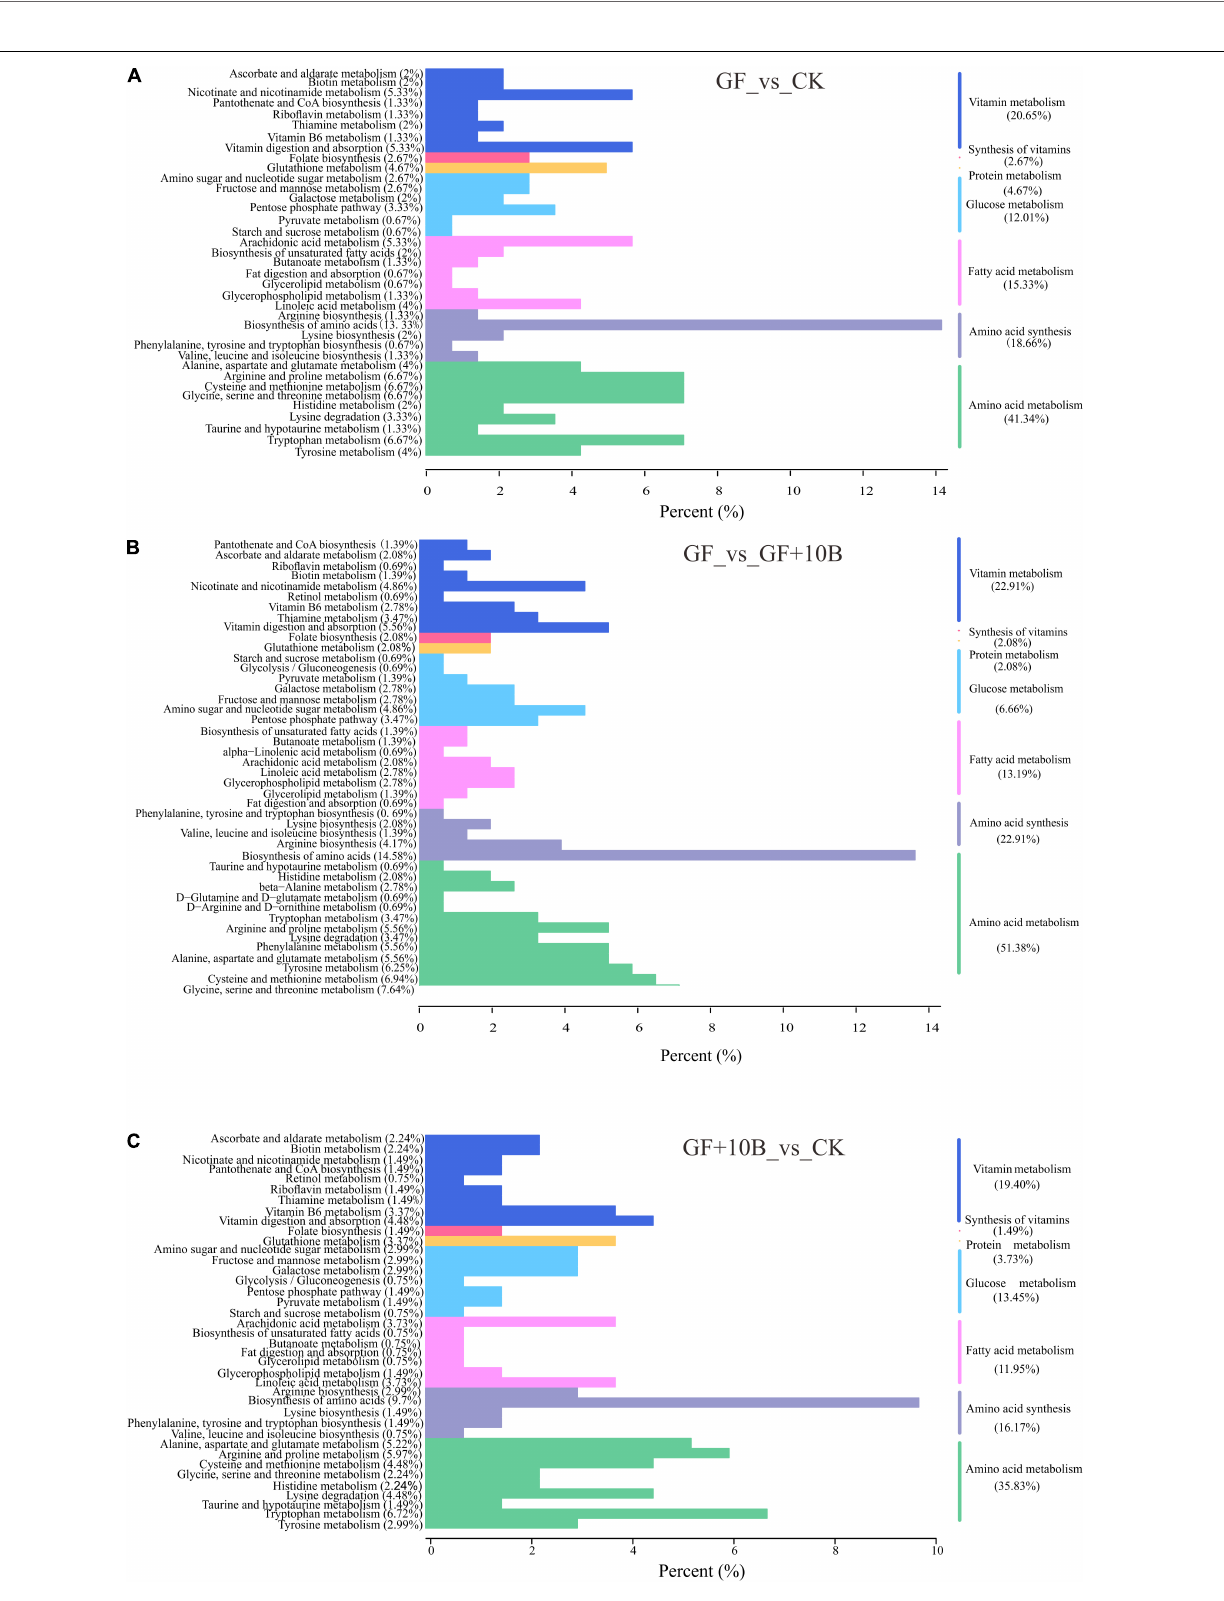
Frontiers in Nutrition |